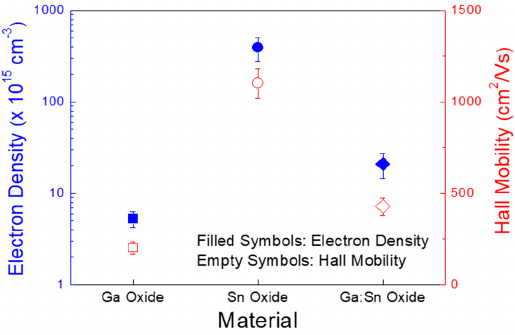
Figure 5. Electron concentrations and Hall mobilities of the Ga oxide, Sn oxide, and Ga:Sn oxide films.